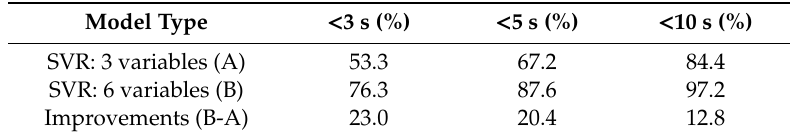
Table 4. The proportion of estimated data depends on the absolute difference between actual dwell time and estimated dwell time by the number of variables of SVR models.